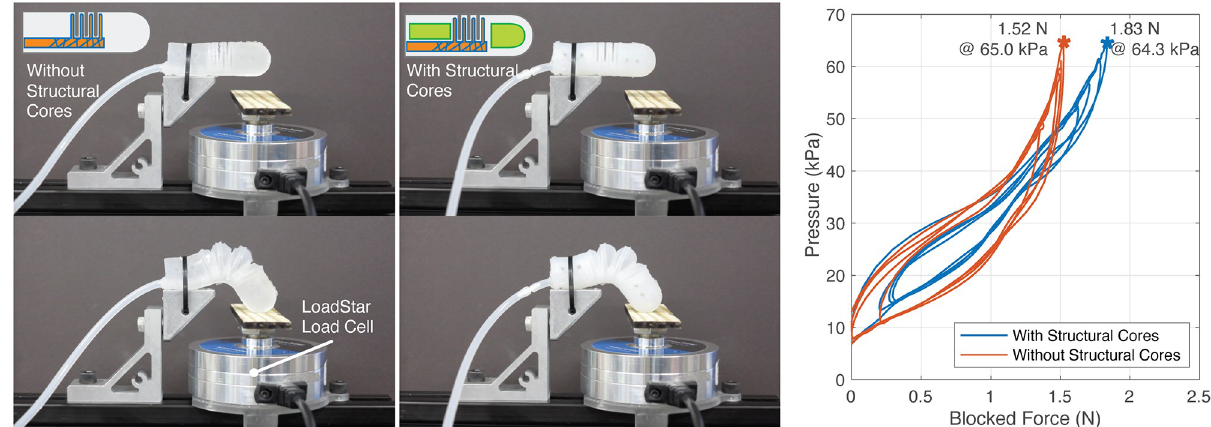
Fig 14. Blocking force output of the bellow-jointed fingers. (Left) The experimental setup. The fingers in the top row are in the idle state the bottom rows are at full flexion. (Right) A plot showing the relation between input pressure and the amount of force exerted by the finger.